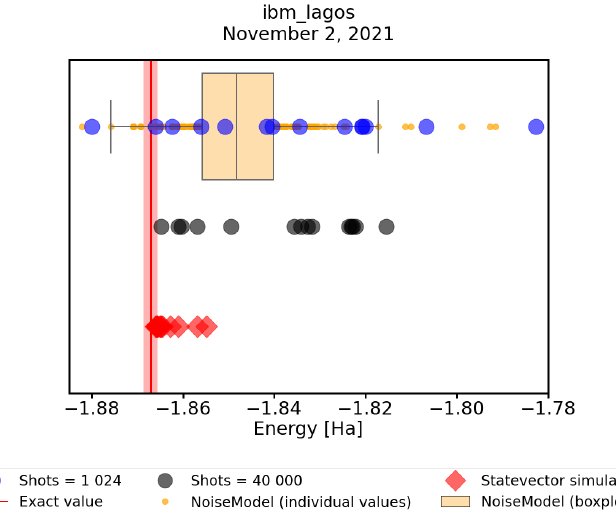
Figure 8. A comparison of results obtained with a noisy quantum simulator with error mitigation (orange points and box plot), with real runs of the ibm_lagos quantum processor (blue points). The energies of real runs were subsequently recalculated with greater precission using 40,000 shots of the ibm_lagos quantum processor (grey points). Finally, we recalculate their energies also with a statevector simulator (red diamonds). The red line represents the physical ground-state energy ( − 1.86712 Hartree) and the light-red background represents the chemical accuracy ( ± 0.0015